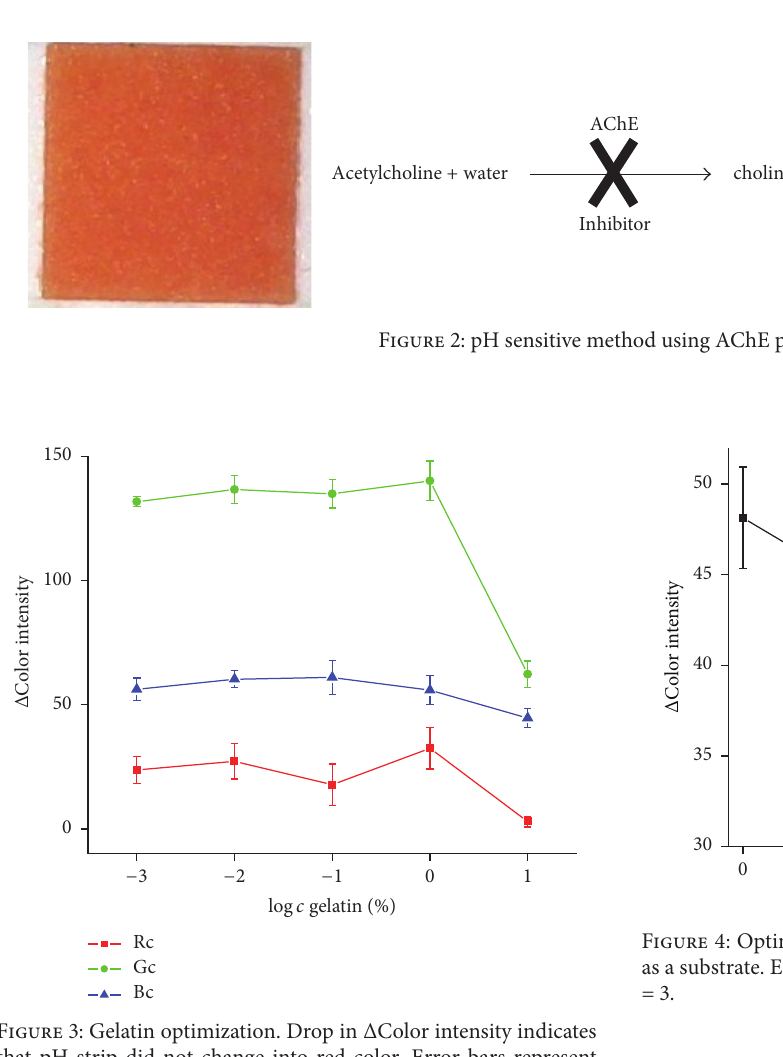
Figure 1: Tube shaped holder printed by 3D print technology (a) and the holder with a smartphone adjusted on the hole to provide photographs by an integrated camera.